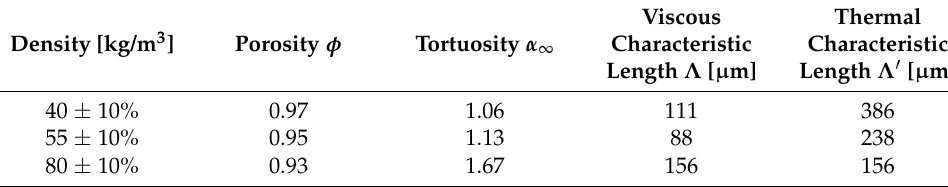
Table 2. Estimated intrinsic parameters from inverse acoustic characterization.